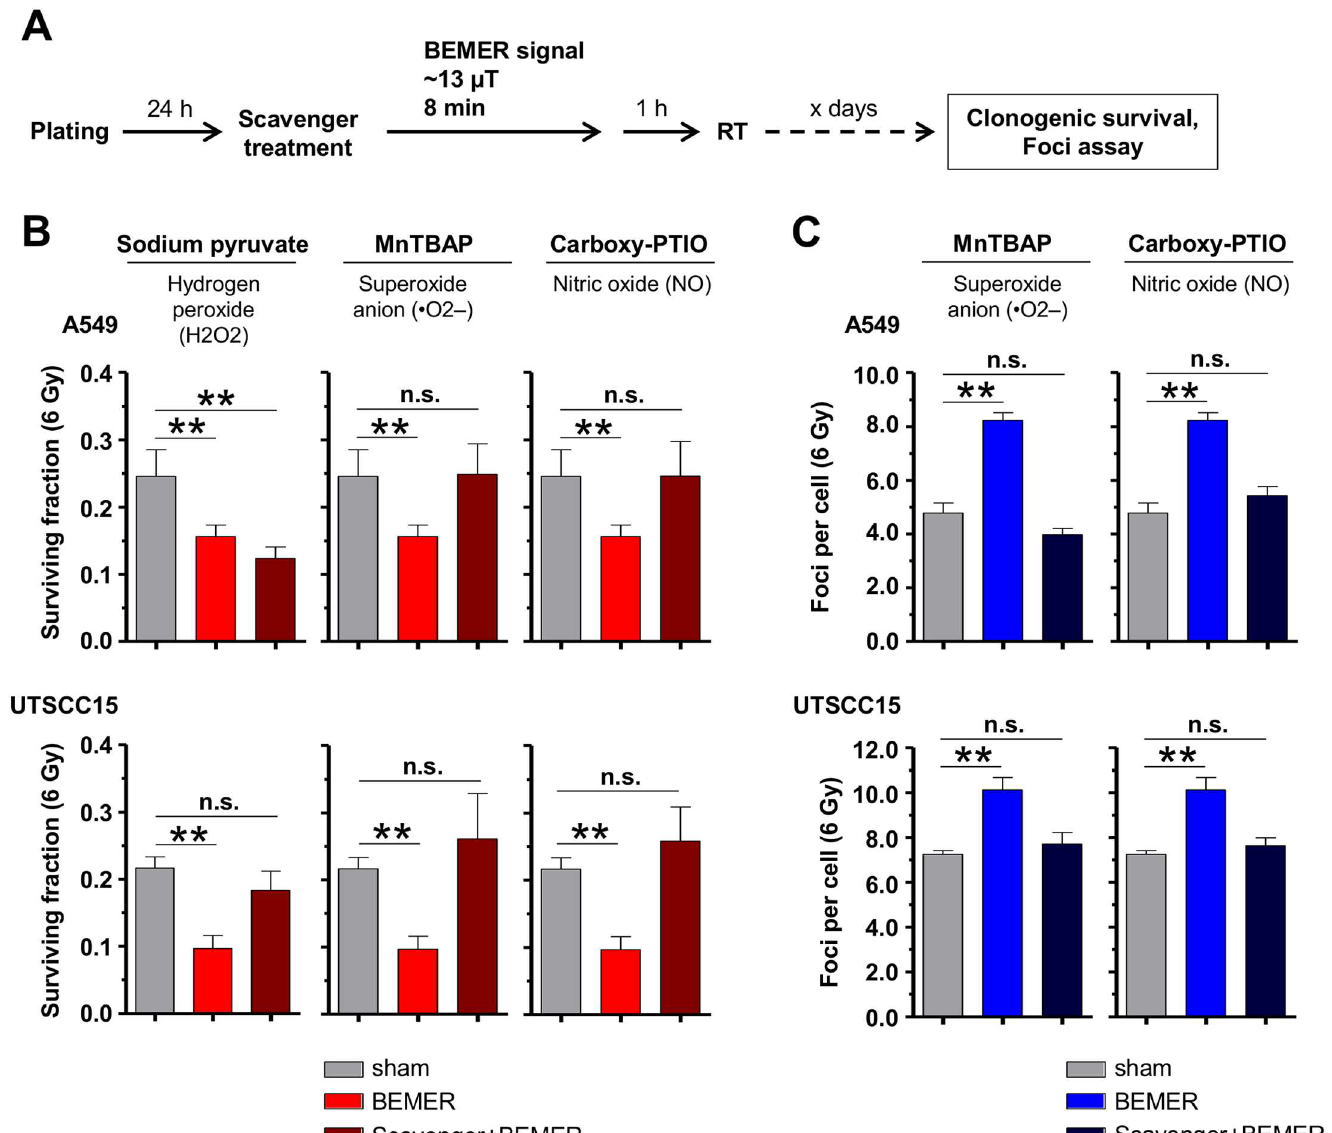
Fig 9. BEMER therapy induces elevated ROS levels resulting in increased DSB numbers. (A) Flow chart of colony formation assay and foci assay. (B) Survivingfraction of indicatedcell lines treated with sodium pyruvate (10 μ M), MnTBAP (50 μ M) or Carboxy-PTIO (50 μ M) in combination with BEMER therapy and radiotherapy. (C) Number of γ H2AX/53BP1-positiveDSBs 24 h after irradiationin A549 and UTSCC15cells. Cells were treated with indicated scavenger agents and BEMER therapy (~35 μ T, 8 min). BEMER sham-treated (sham), irradiatedcells served as control. All results represent mean ± SD. Student’s t-test. n = 3. ** P < 0.01. n.s., not